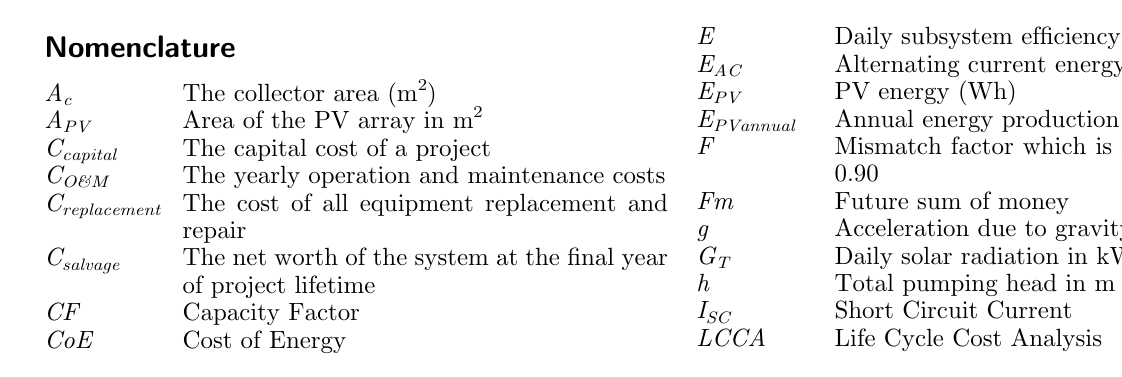
Fig. 7. Cost of energy of different systems.